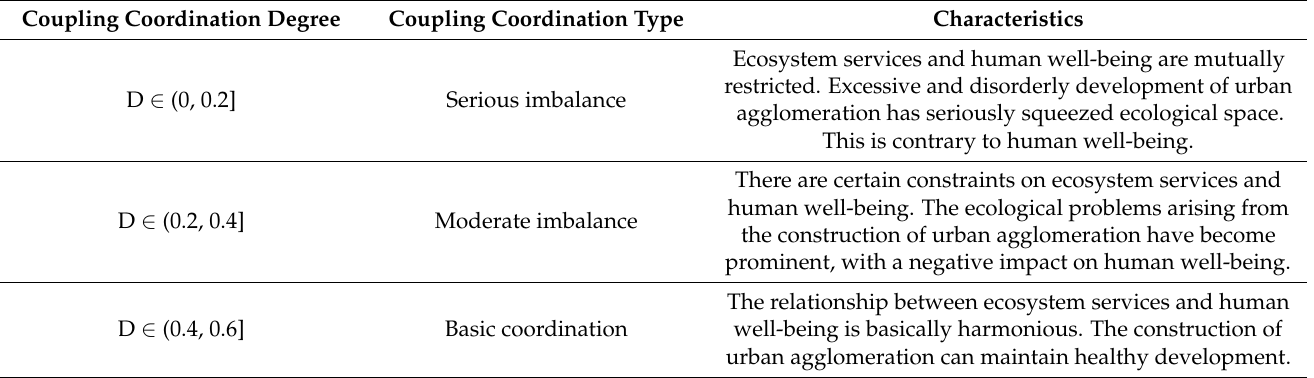
Table 2. Types of coupling coordination degree between ecosystem services and human well-being. Coupling Coordination